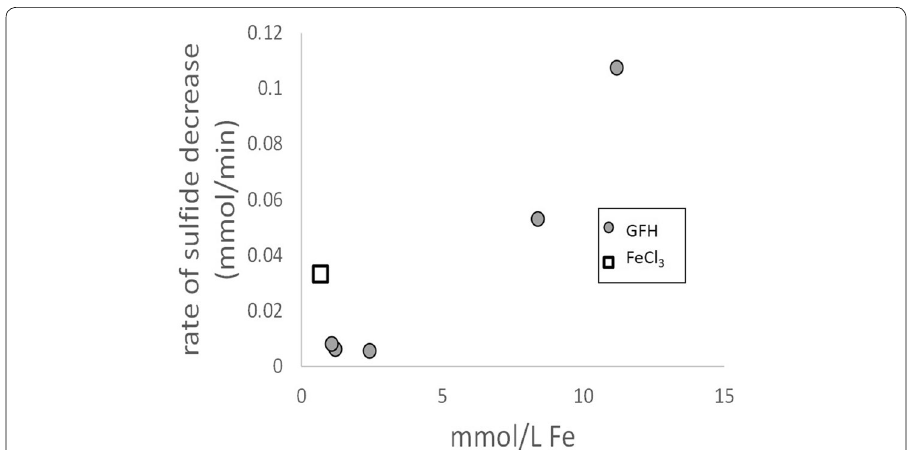
Fig. 12 Rate of hydrogen sulfide decrease per added amount of Fe(III) for all experiments ( a – e ). Grey dots indicate experiments with GFH as additive and the white square the one using FeCl